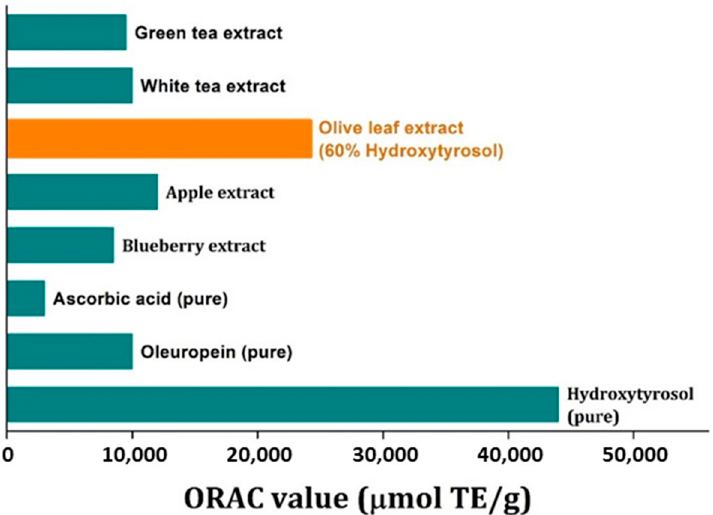
Figure 12. Comparison of the ORAC value of the purest in hydroxytyrosol extract and the ORAC value of commercial extracts and pure substances.